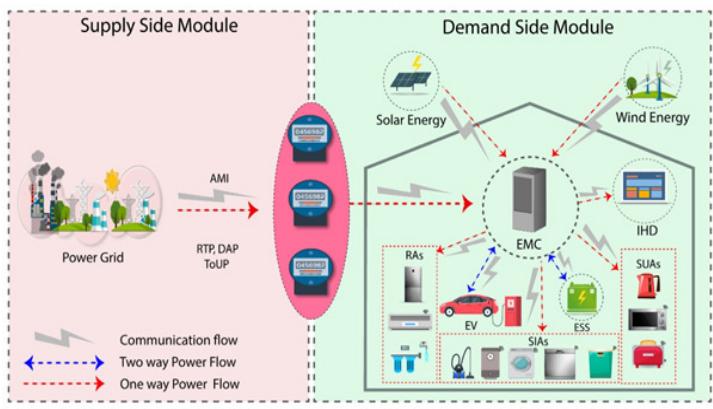
Figure 1. Developed framework for optimal DSM in